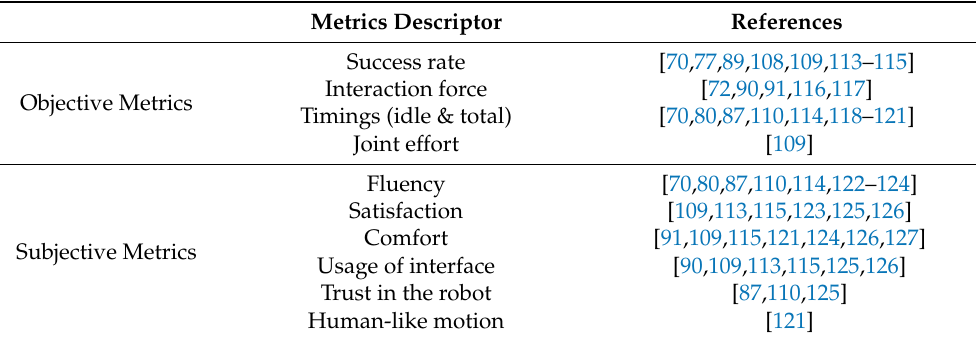
Table 2. List of works addressing distinct metrics for Human-Robot Collaboration. Metrics